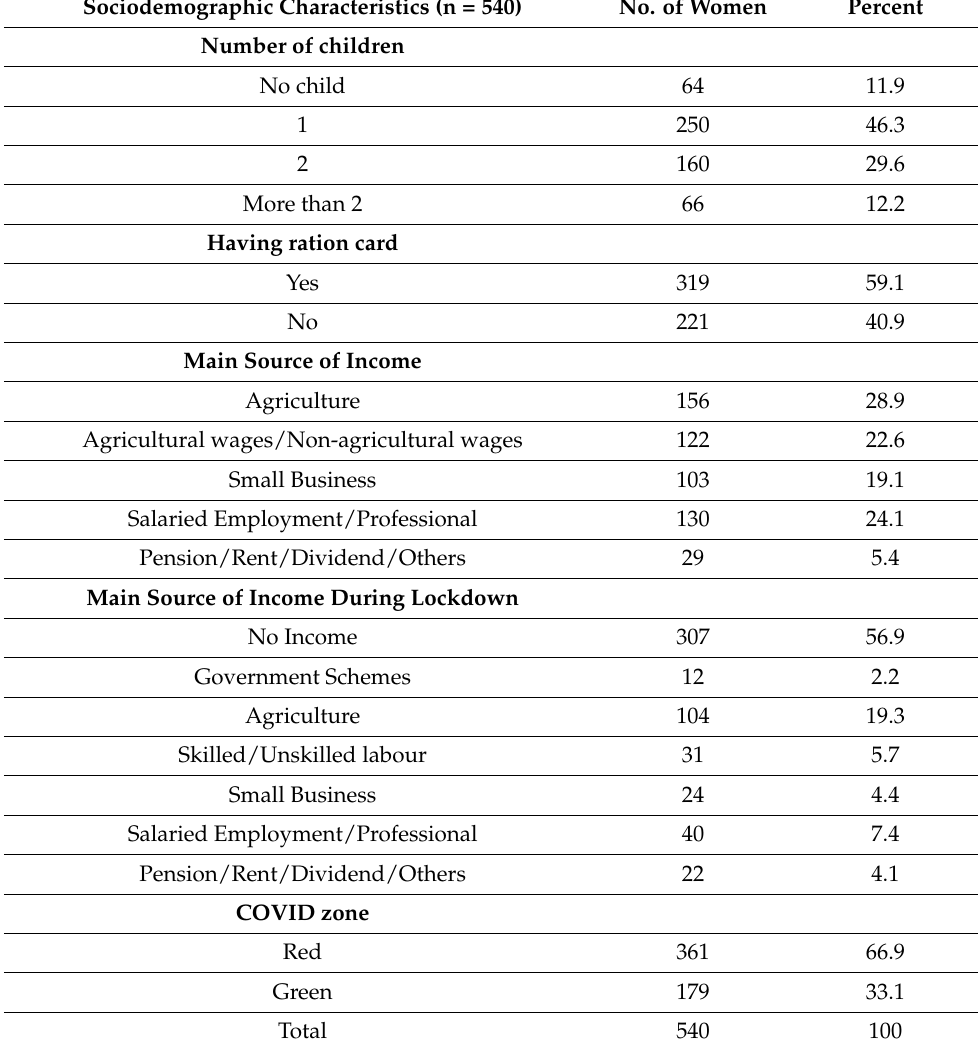
Table 1. Cont. Sociodemographic Characteristics (n =